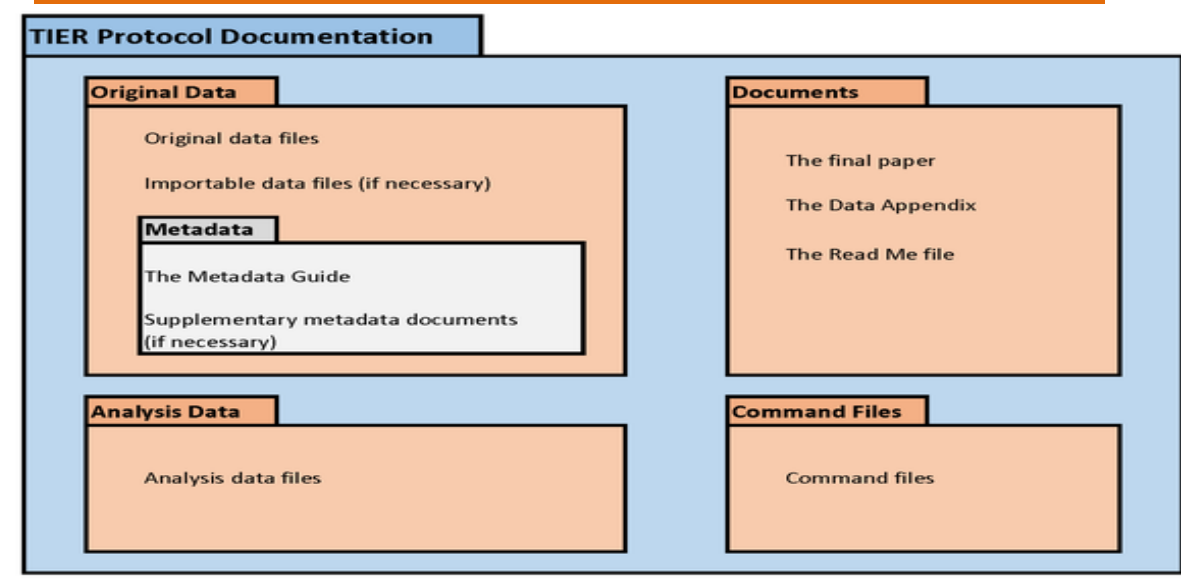
Figure 04. TIER Protocol